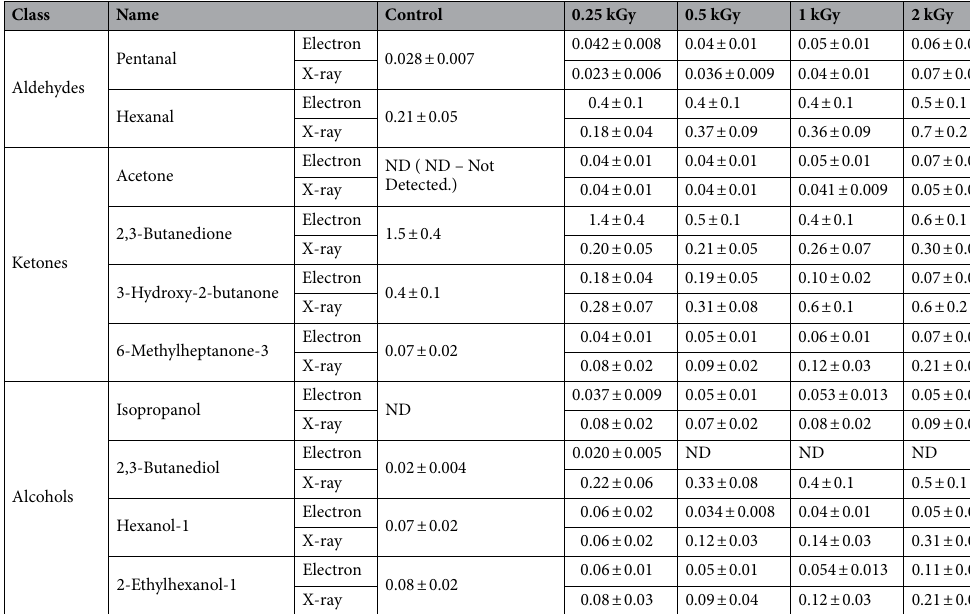
Table 1. The content of identified volatile compounds in the turkey samples (mg/kg; n = 3 is the number of repeats, P = 0.95 is the confidence level). ND not